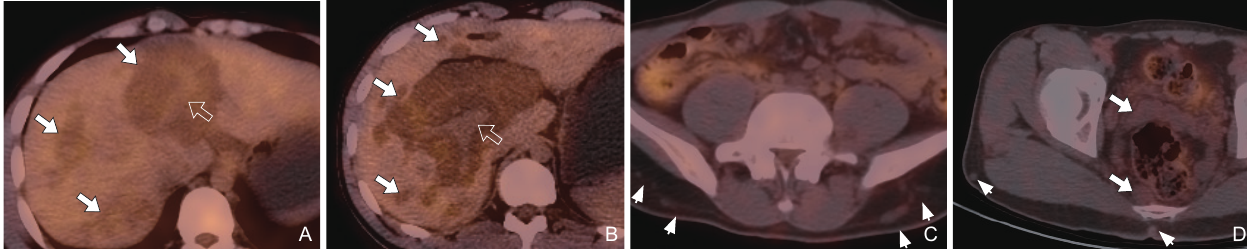
Figure 3 Positron emission tomography-computed tomography (PET-CT). (A, B) PET-CT showed a wide-extended intra-abdominal mass with slight-elevated FDG uptake (solid arrows). The portal vein (open arrow) integrately distributes through the lesion. Multiple cutaneous nodules could be observed around waist and buttock (arrowheads in C and D). The mass extends inferiorly into the retroperitoneum and pelvic cavity (arrows in D). The FDG-uptake of both internal and cutaneous nodules were minimal.